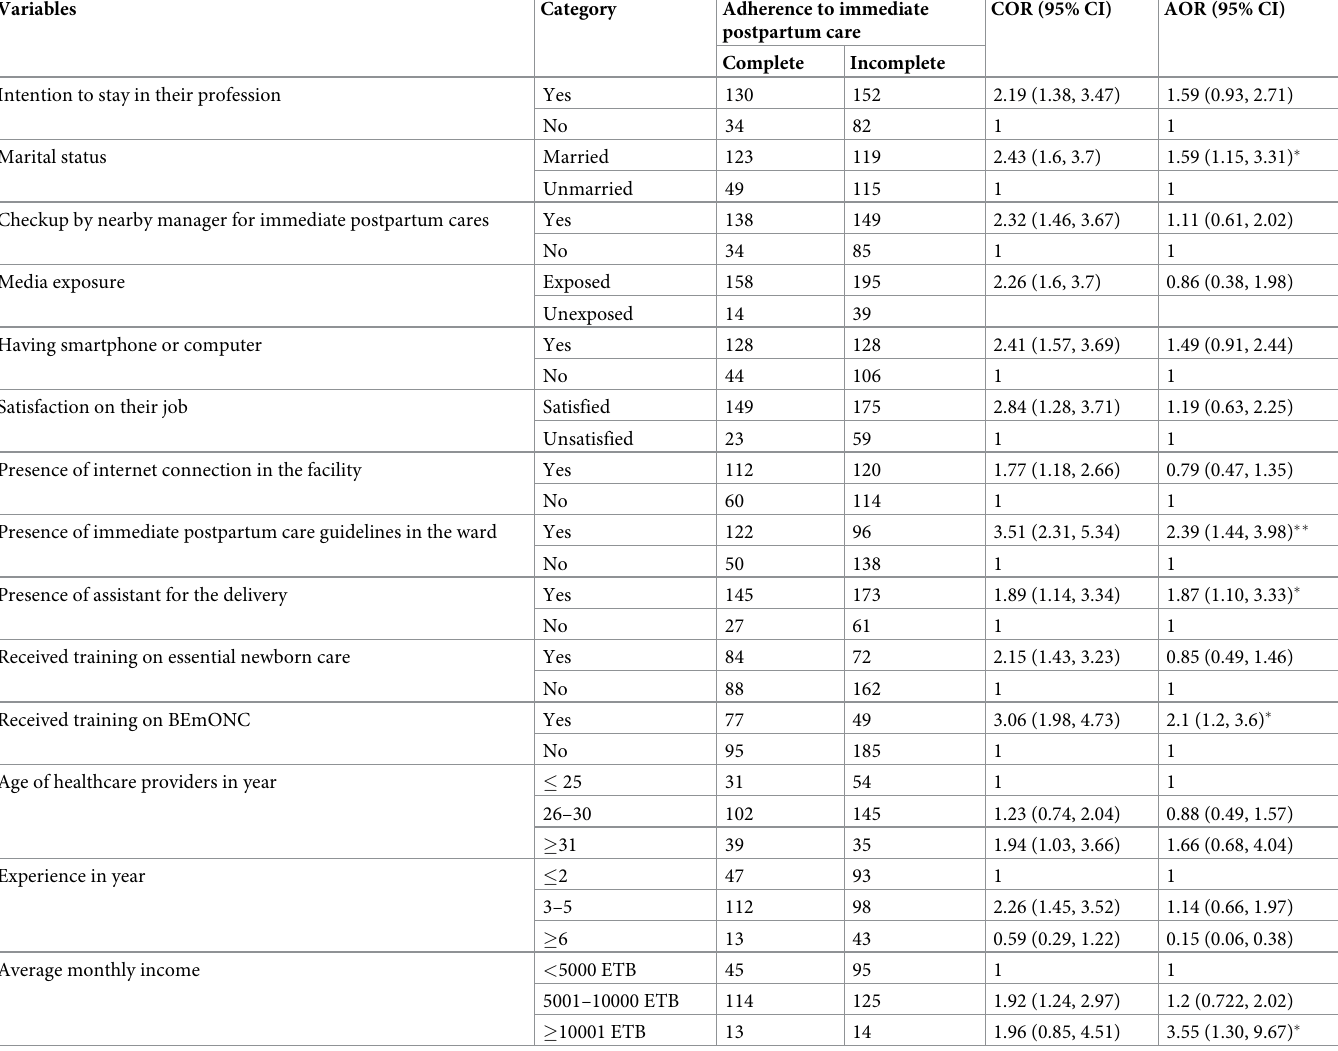
Table 4. Factors associated with immediate postpartum care guidelines among healthcare provider’s at hospitals in Gondar province, northwest Ethiopia, 2020/ 2021 (n =